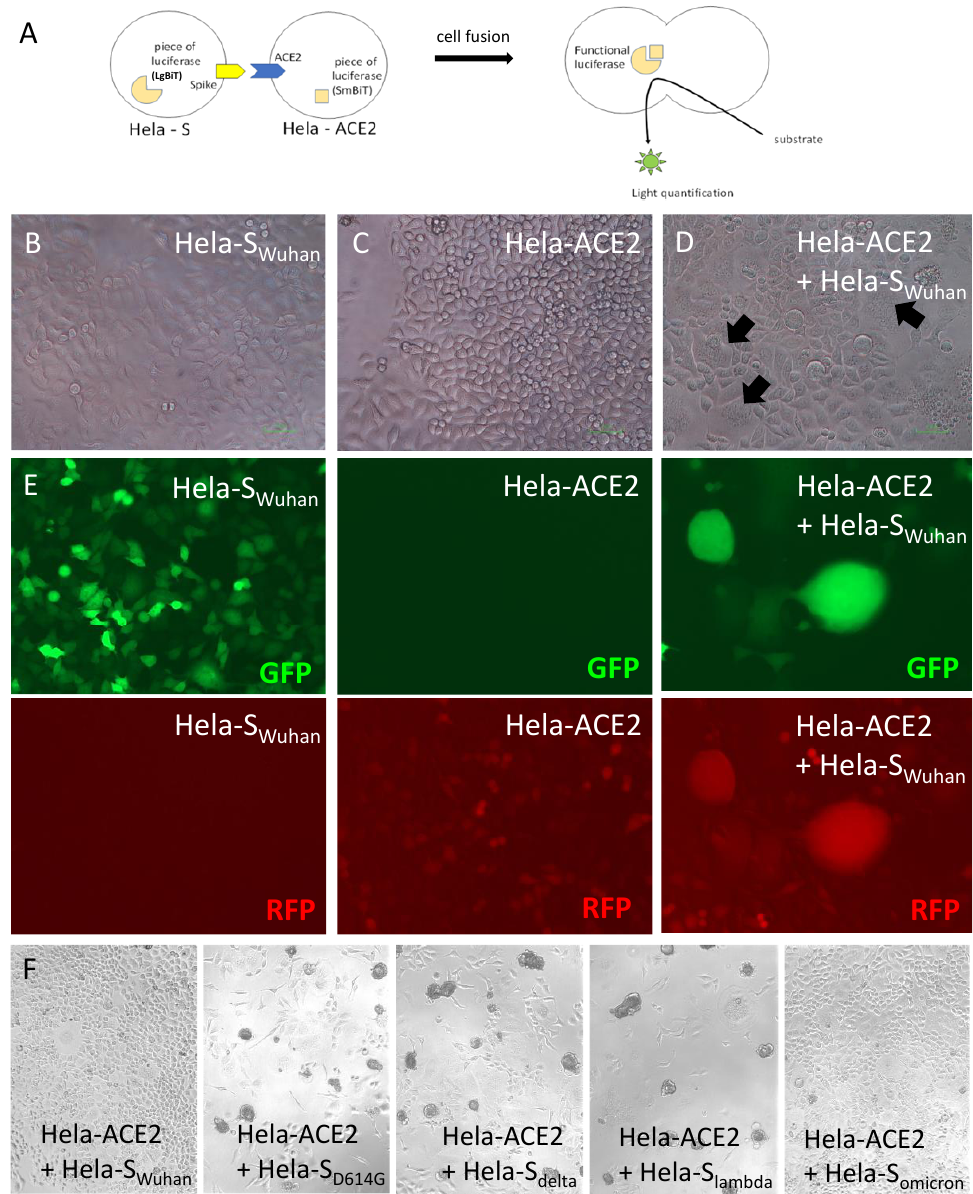
Figure 1. Coculture of Hela-S and Hela ACE2 induces cell fusion. ( A ) Principle of the dual split fusion assay between a Hela-S and a Hela-ACE2. B-F Cells were cultured in 96-well plate for 24 h. ( B – D ) Microscopic observation of Hela-S ( B ) or Hela-ACE2 ( C ) alone versus co-culture ( D ). The black arrows show cell syncitia indicative of fusion. Magnification × 40. ( E ) Observation of the fluorescence emitted by Hela-S or Hela-ACE2 alone versus co-culture. Hela-S were GFP+ and Hela- ACE2 RFP+. Magnification × 40. ( F ) Hela cells expressing various variants of Spike were cocultured with Hela-ACE2, prior to a microscopic observation of cells. Magnification ×